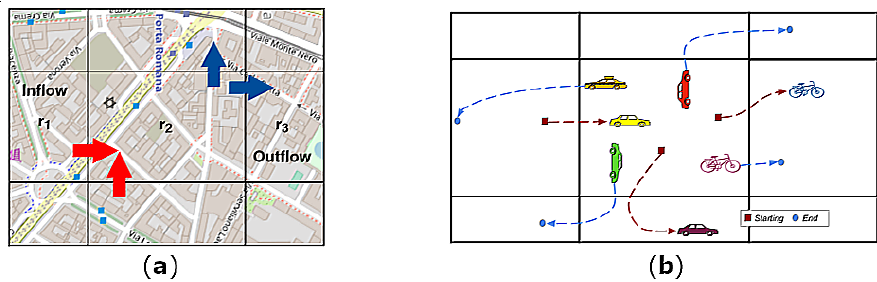
Figure 1. Measurement of flows. ( a ) Inflow and Outflow; ( b ) Measurement of